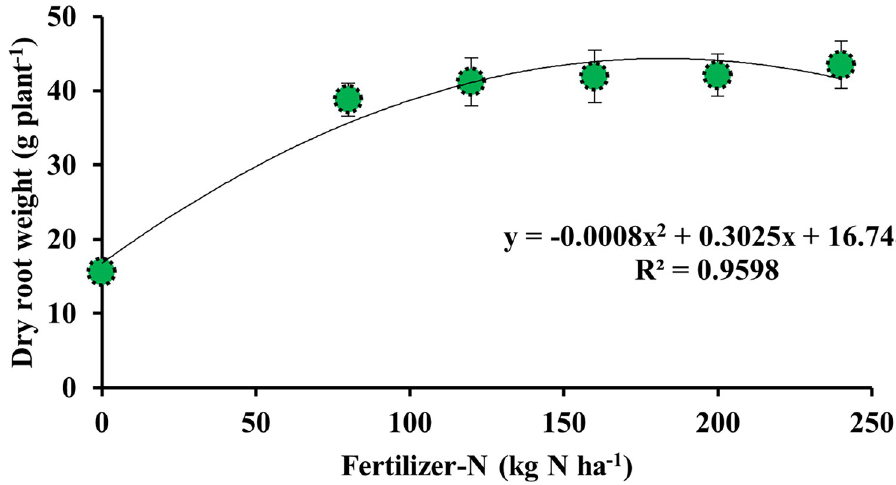
Fig 1. Relationship between fertilizer-N application rate (kg N ha -1 ) and dry root weight (g plant -1 ) of wheat ( Triticum aestivum L.) in a sandy loam soil. Line bars indicate standard error from mean (S . E . M